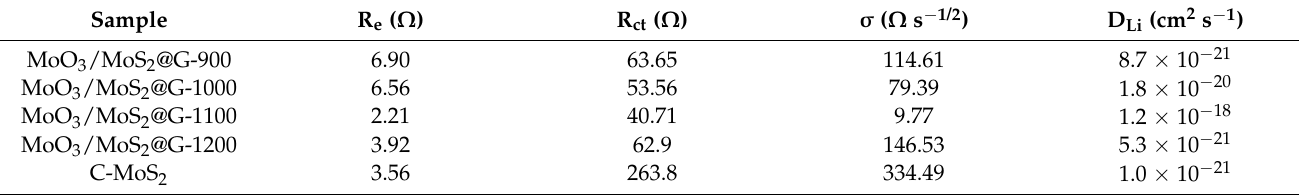
Table 4. Electrode kinetic parameters for the MoO 3 /MoS 2 @G and C-MoS 2